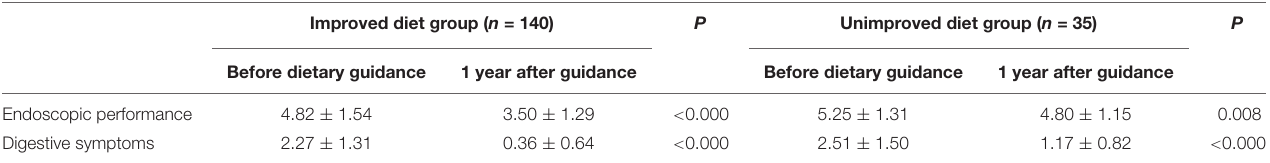
TABLE 3 | Comparison of endoscopic performance scores and symptom scores between the diet improvement group and the diet non-improvement group before and after dietary guidance. Improved diet group ( n = 140)